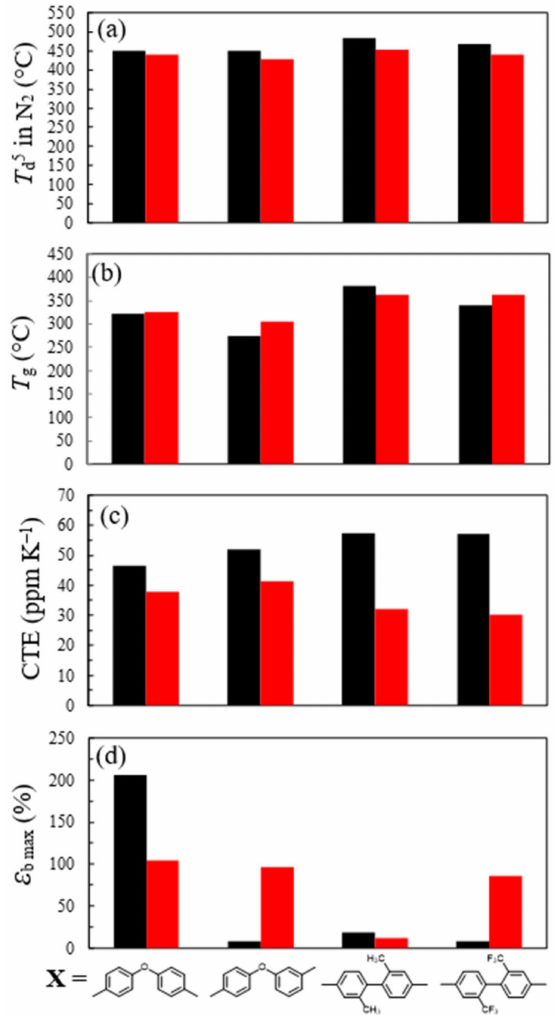
Figure 10. Comparisons of the properties of the GBL-cast films for the H-PMDA-based PIs obtained from common diamines (H 2 N-X-NH 2 , left (black) bars) and the related bisamide-type diamines (AB-X, right (red) bars): ( a ) T d5 in N 2 ; ( b ) T g ; ( c ) CTE; ( d ) ε b max